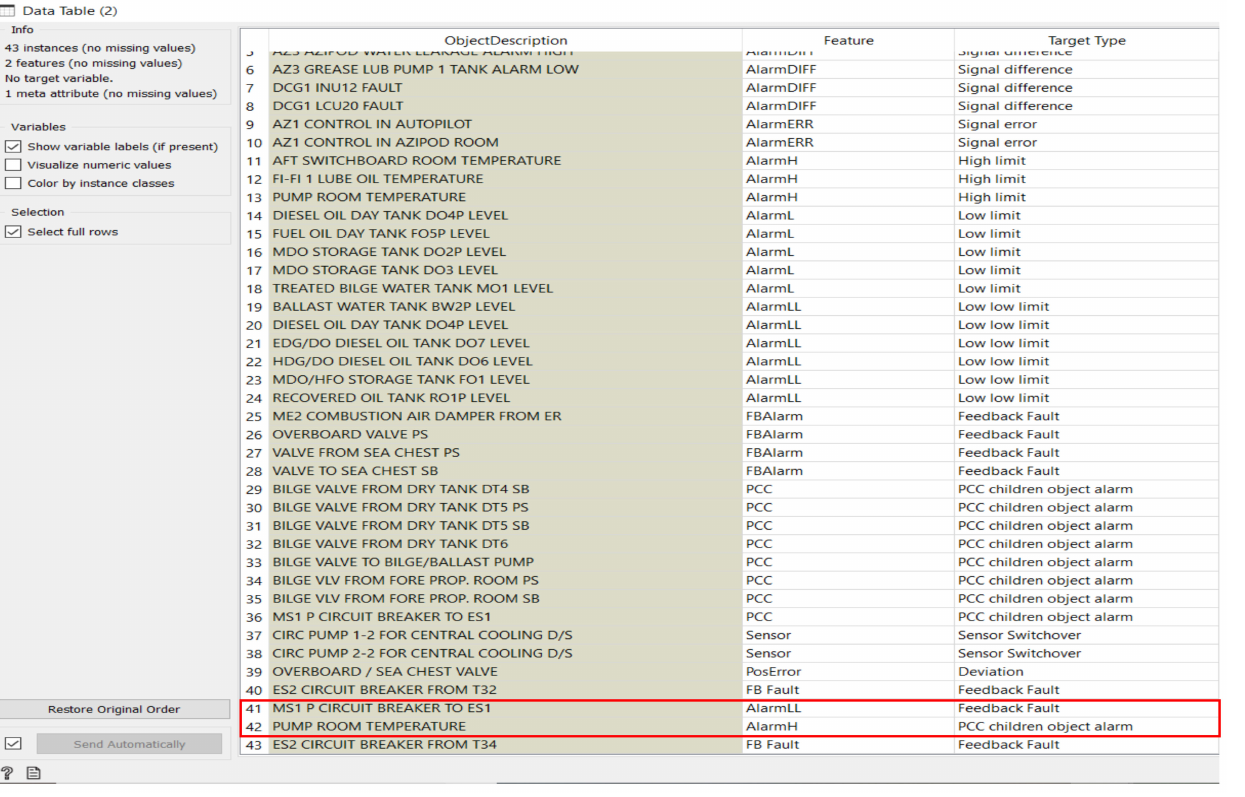
Figure 14. Misclassified data: at line 41 and 42 target types do not correspond to